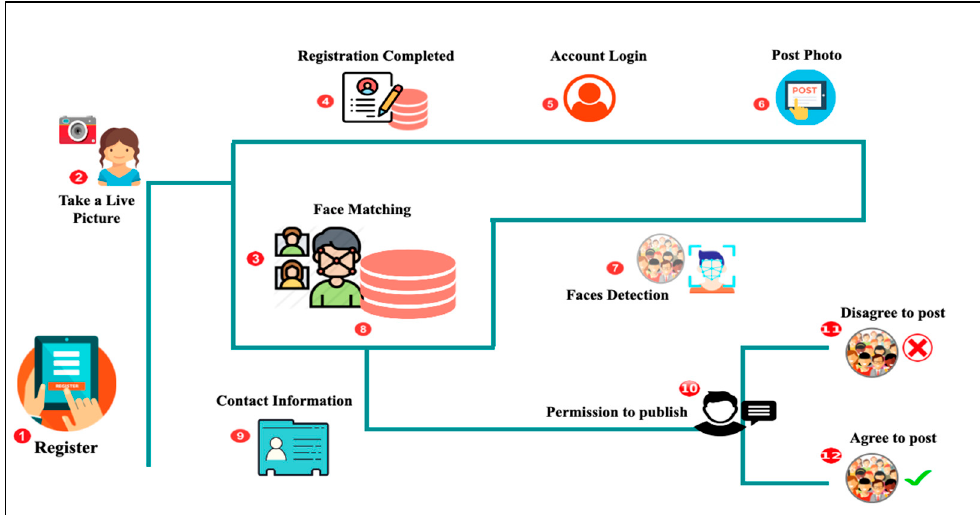
Figure 1. An Abstract System Model.